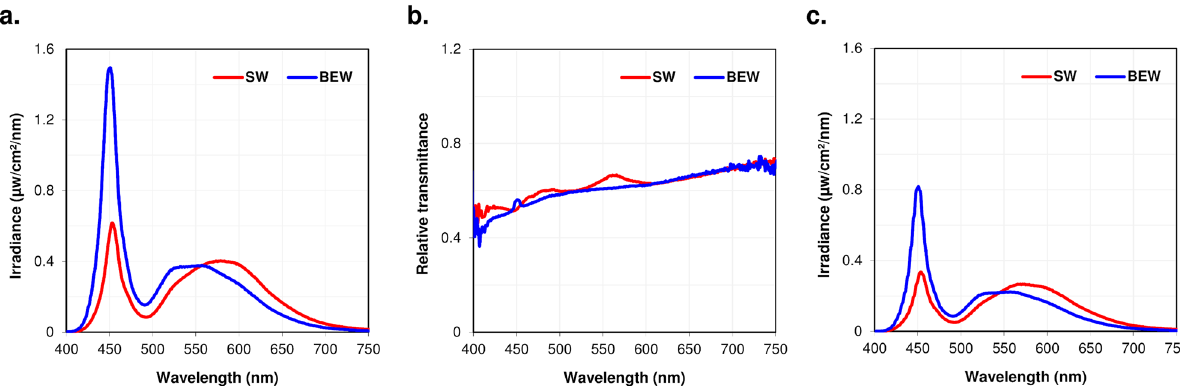
Figure 1. Spectral composition of light reaching control and FDEP eyes. ( a ) Spectral composition of the lighting environments in both SW and BEW groups measured at the corneal level of control eyes. ( b ) Relative spectral transmittance of the diffusers used for form-deprivation. ( c ) Spectral composition of the lighting environments in both SW and BEW groups measured with the diffuser at the corneal level of a FDEP 10.7 h less time outdoors per week and are 26% more at risk of becoming myopic than children of Chinese ethnicity living in Sydney 20 . The impact of the spectral composition of light on emmetropization and homeostatic control of ocular growth in humans remains unclear, however, evidence for a role of color vision in the control of eye growth has been reported in a school-based study showing that the incidence of myopia is lower in children with protan or deutan color deficiencies compared to children with normal color vision 28 . Similarly, lab-based studies highlighted a decreased sensitivity to low spatial frequency short-wavelength cones (S-cone) stimuli in myopes compared to emmetropes 29 , and a correlation between refraction and the relative sensitivity of the accommodation system to long-wavelength cones (L-cones) contrast 30 . In animal models, findings from our lab and others suggest that modulating the spectral composition of light can affect ocular growth and refractive error development. For instance, in fish, squid, guinea pigs and chickens, eyes become more myopic under long wavelength light and more hyperopic under short wavelength light 22,31–36 , and exposing chickens to narrow-band blue light reduces